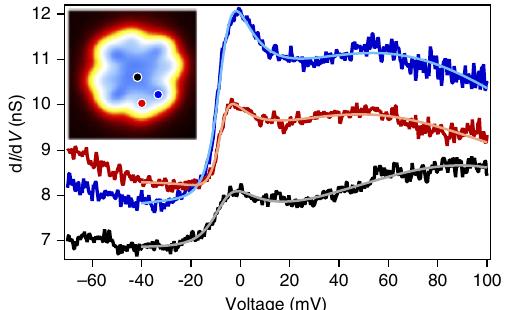
Figure 2 | Spatial variation of Fano line shape. d I /d V spectroscopy ( V set ¼ (cid:3) 70mV, I set ¼ 0.5nA) acquired over the centre (black) and two sides (red and blue) of the top ligand of the DyPc 2 molecule, vertically offset for clarity. A clear difference in amplitude is observed on alternating sides of the ligands. A Fano feature is observed near 0V, along with a broad peak centred at B 50–60mV on the upper Pc ligand and at B 90mV at the centre of the molecule. Solid lines show a fit with a Fano line shape and a Gaussian. Inset shows a constant current topographic image ( V set ¼ 0.1V, I set ¼ 0.1nA) of DyPc 2 ; the position at which each spectrum shown has been acquired is marked in the corresponding